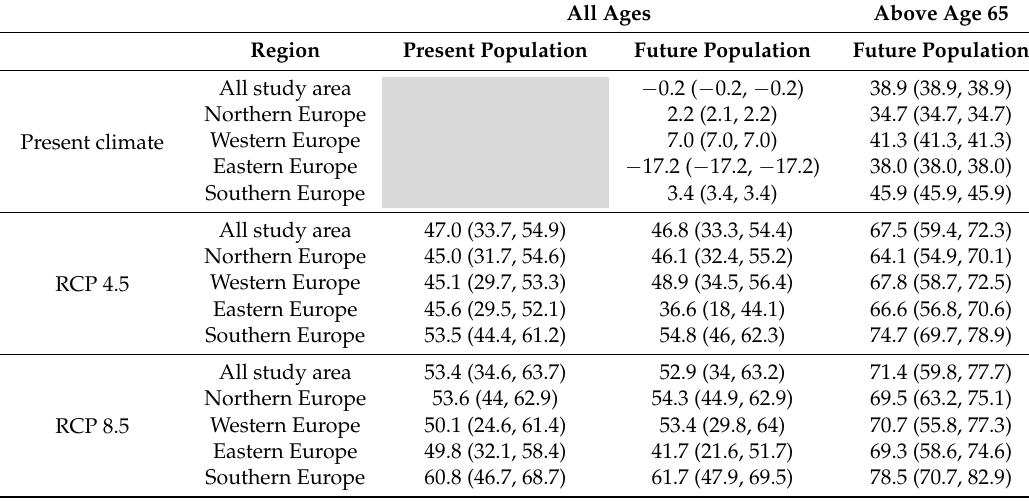
Table 1. Estimated Adaptive Risk Reduction (ARR) (percent) needed for four European regions to maintain current levels of risk, comparing present and future populations (all ages and adults over 65 years of age), and present and projected climate in the 2050s under Representative Concentration Pathway (RCP) 4.5 and RCP